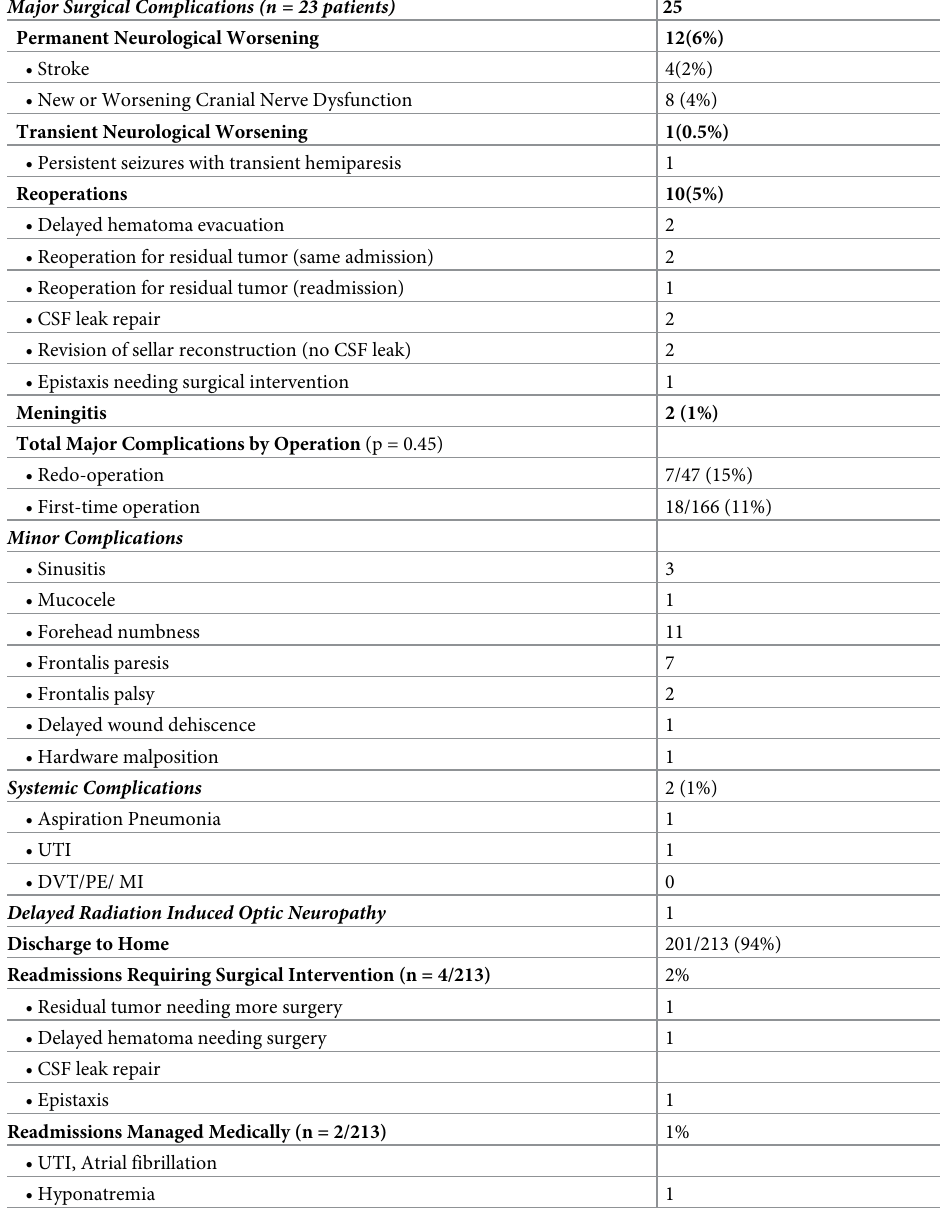
Table 4. Major and minor complications, readmissions, reoperations and discharge status in 193 patients under- going 213 keyhole operations for meningioma. Major Surgical Complications (n = 23 patients) 25 Permanent Neurological Worsening 12(6%)